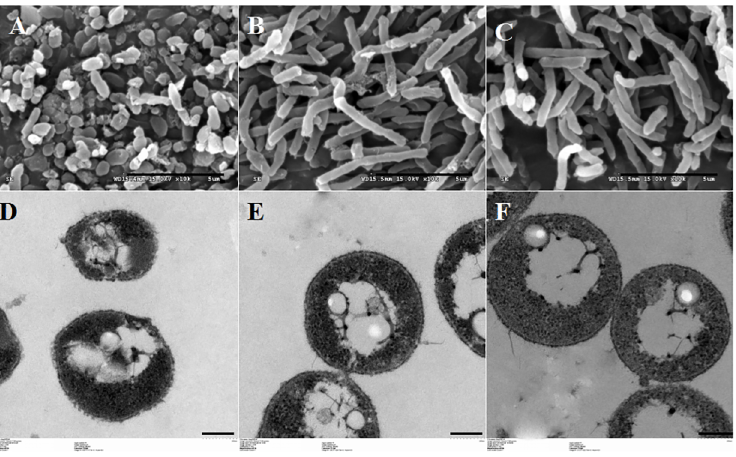
Fig 1. Electron micrographs of Natrinema sp. J7-2 cells in media of different salinities. A, B, and C indicatethe morphologyof cells incubatedin 15%, 25% and 30% NaCl media, respectively;the magnification is 10,000-fold; Bar, 5 μ m. D, E and F represent the thin-section electron microscopy of the cells cultured in 15%, 25% and 30% NaCl; the magnification is 7,000-fold;Bar, 1 μ